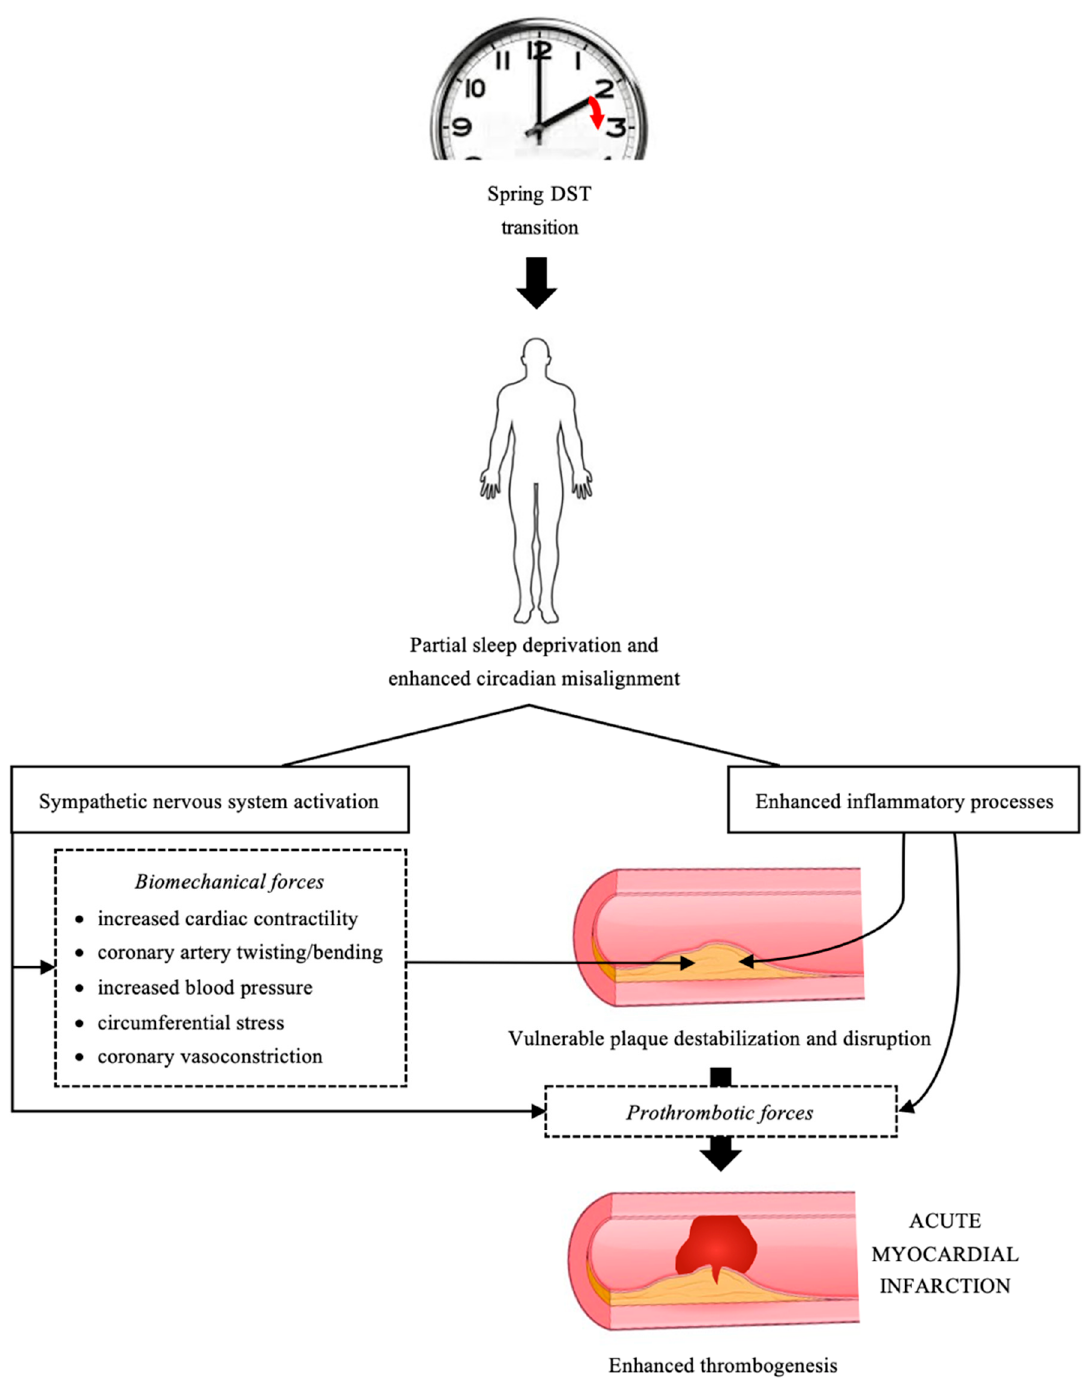
Figure 2. Mechanisms of increased risk of acute myocardial infarction in the period after the spring daylight saving time (DST) transition. Increased inflammation coupled with enhanced hemodynamic and biomechanical forces induced by sympathetic nervous system arousal can cause destabilization of vulnerable coronary atherosclerotic plaque. As those processes accompany the circadian clock misalignment and partial lack of sleep and last over a several week period, they could initiate a superficial erosion of the intimal surface or rupture of a vulnerable plaque. Increased inflammation and sympathetic nervous system activity can also initiate formation of an overlaying thrombus and/or facilitate enhanced thrombus growth, to produce a more significant coronary occlusion during the infarction onset.